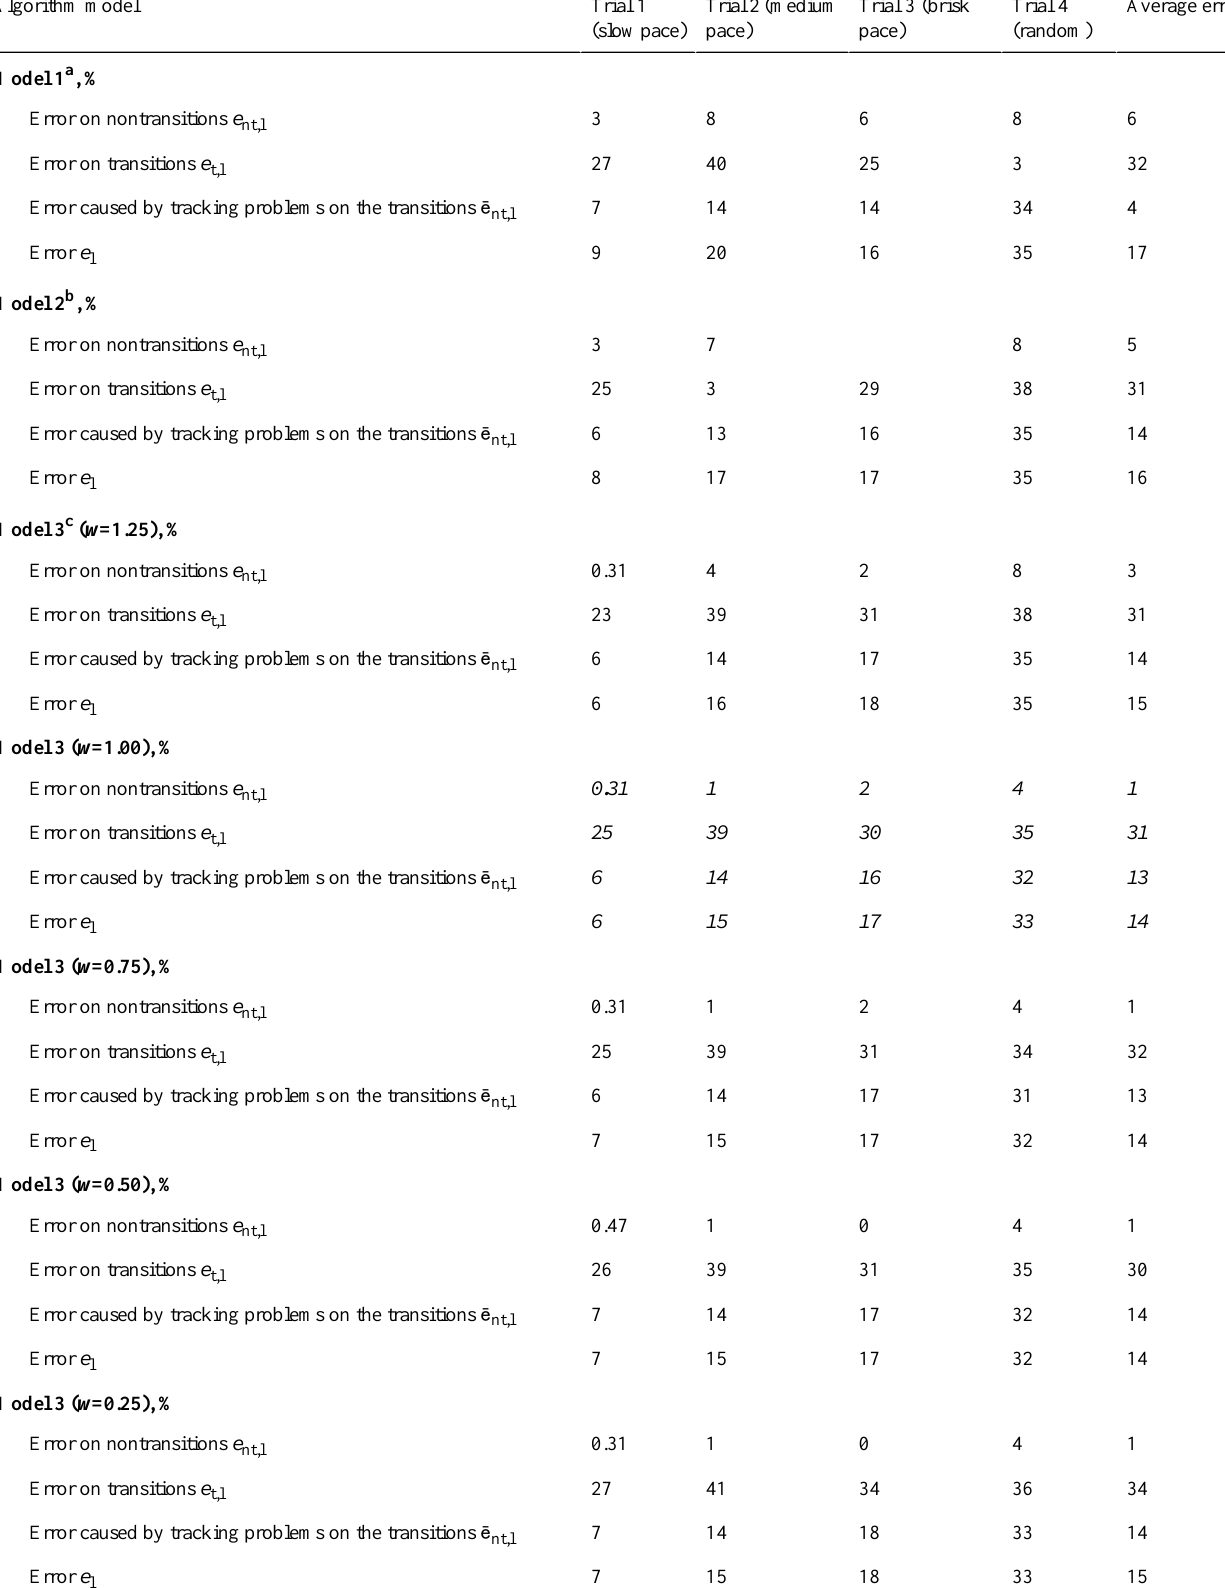
Table 1. Percentage error of transition and nontransition states for each trial and algorithm model. Italics is used to reflect the model that showed the best results. The letter w is the